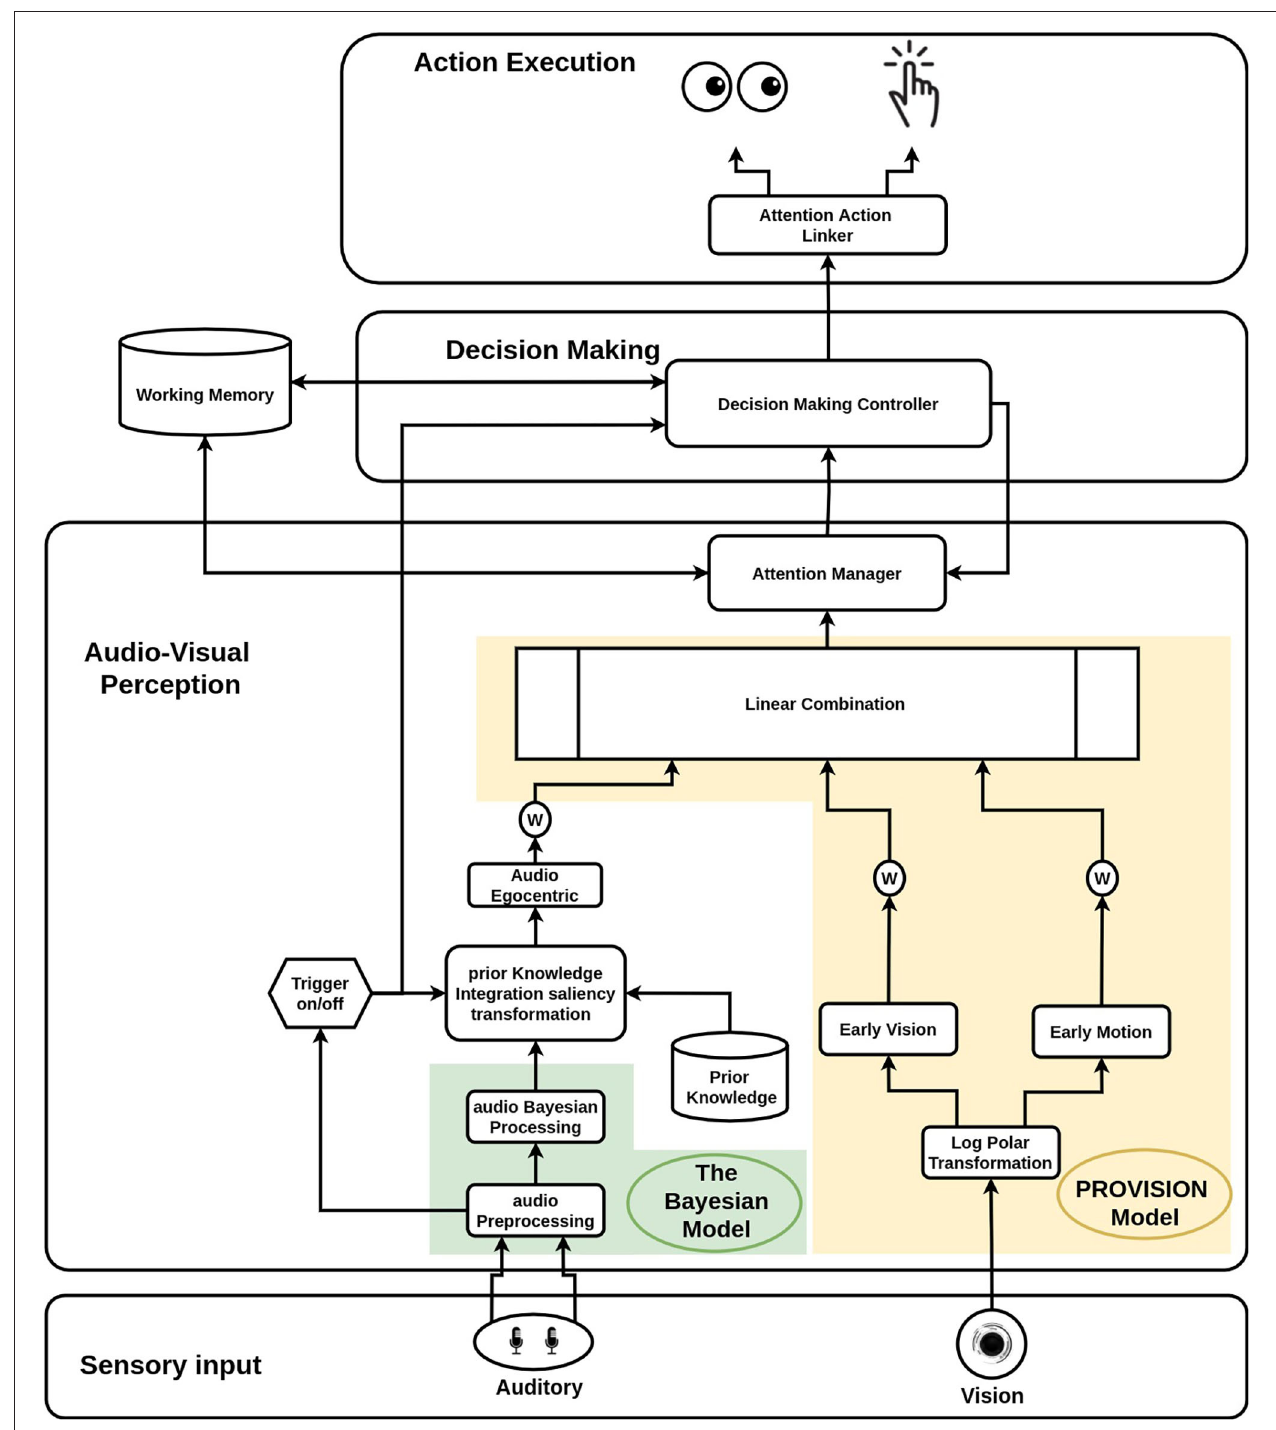
FIGURE 2 | Detailed representation of the system implementation architecture.